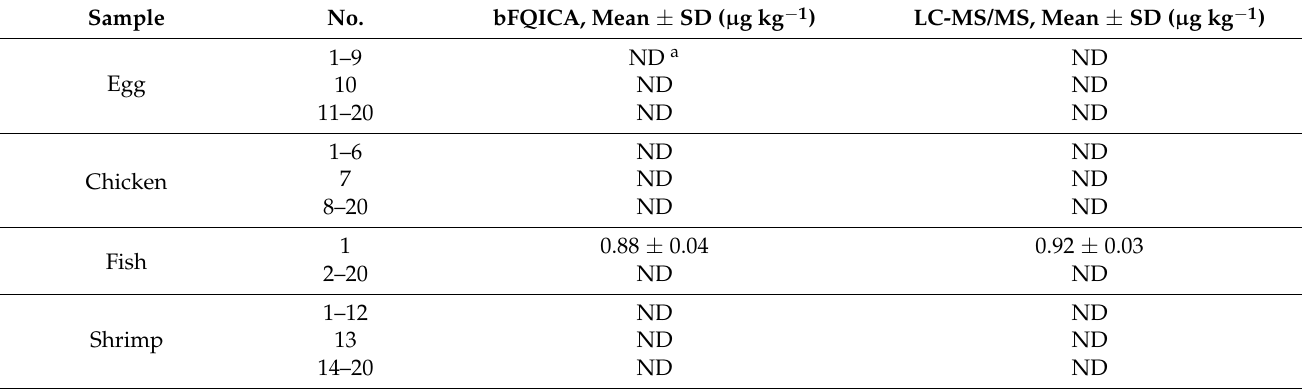
Table 3. Determination of SEM in field animal-derived food samples collected by the bFQICA and LC-MS/MS ( n = 3).